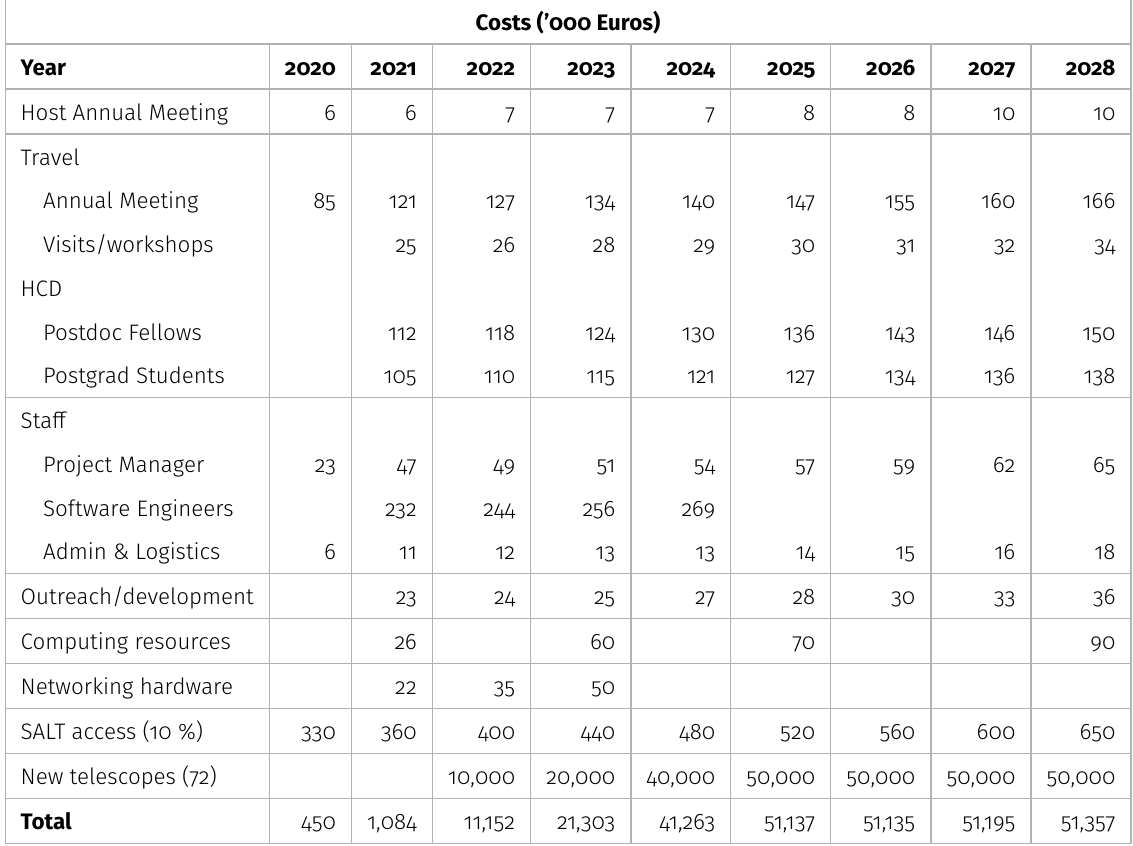
Table I. Cost Estimates for